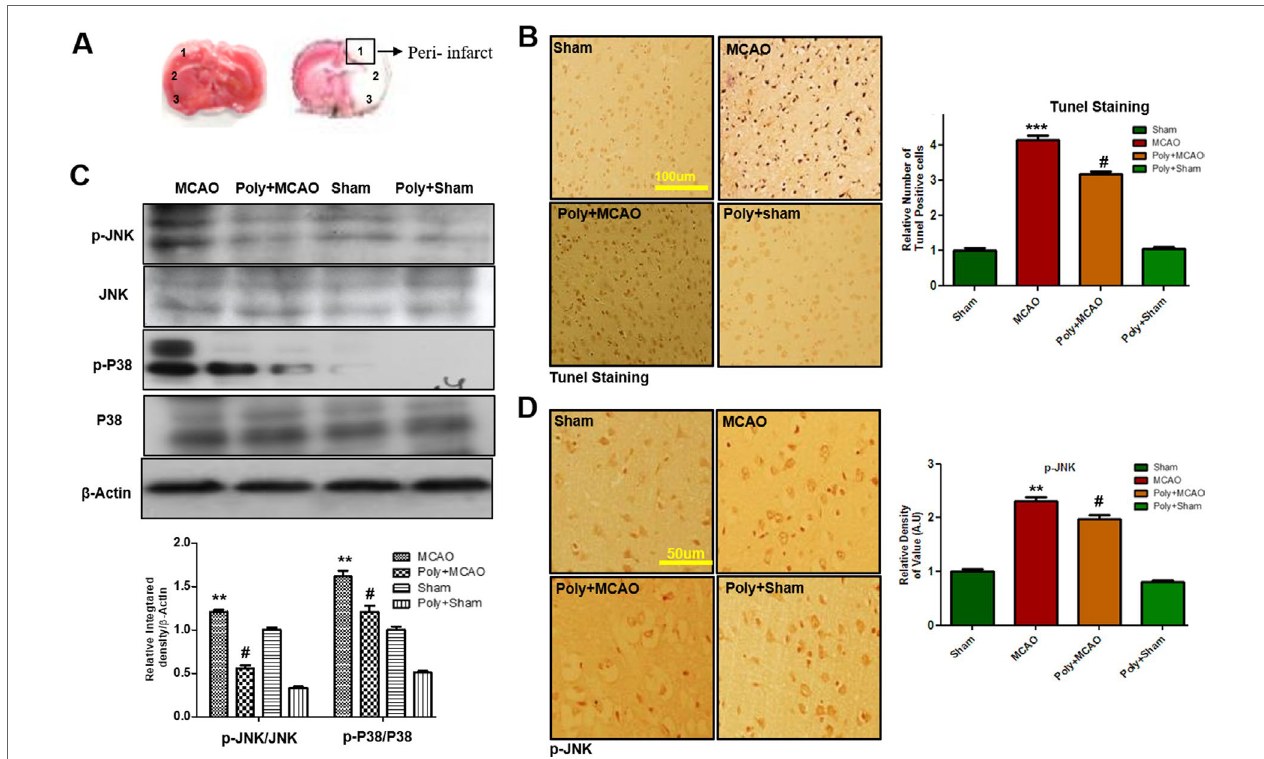
FIGURE 2 | Effect of polydatin on neuronal apoptosis and MAP kinase pathways. (A) TTC staining of coronal sections 24 h after permanent MCAO, separated by frontal cortex (1), parietal cortex and insular cortex (2), and periform cortex (3). The analyzed peri-infarct region, region of interest indicated by square 1 (B) Representative images of TUNEL histochemistry show apoptotic cells; scale bar = 100 μm. MCAO caused significant neuronal apoptosis, while polydatin treatment attenuated apoptotic damage. Data presented are relative to Sham (n = 3–5/group). (C) Polydatin prevents MCAO-induced activation of p-p38 and p-JNK. Representative Western blots of p-p38 and p-JNK (n = 5–8/group) and β -actin was used as a control. (D) Immunoreactivity of p-JNK; scale bar = 50 μm. p-JNK exhibits cytoplasmic localization, and number of experiment performed = 3. *** p < 0.001; ** p < 0.01; # p <